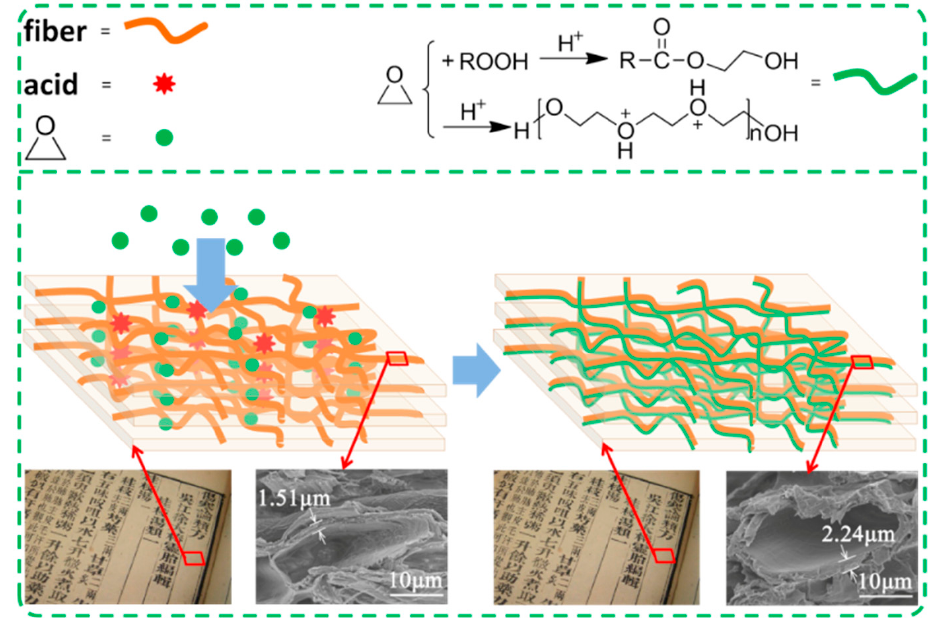
Figure 7. Possible mechanism of EO-Ar treatment on paper fibers.